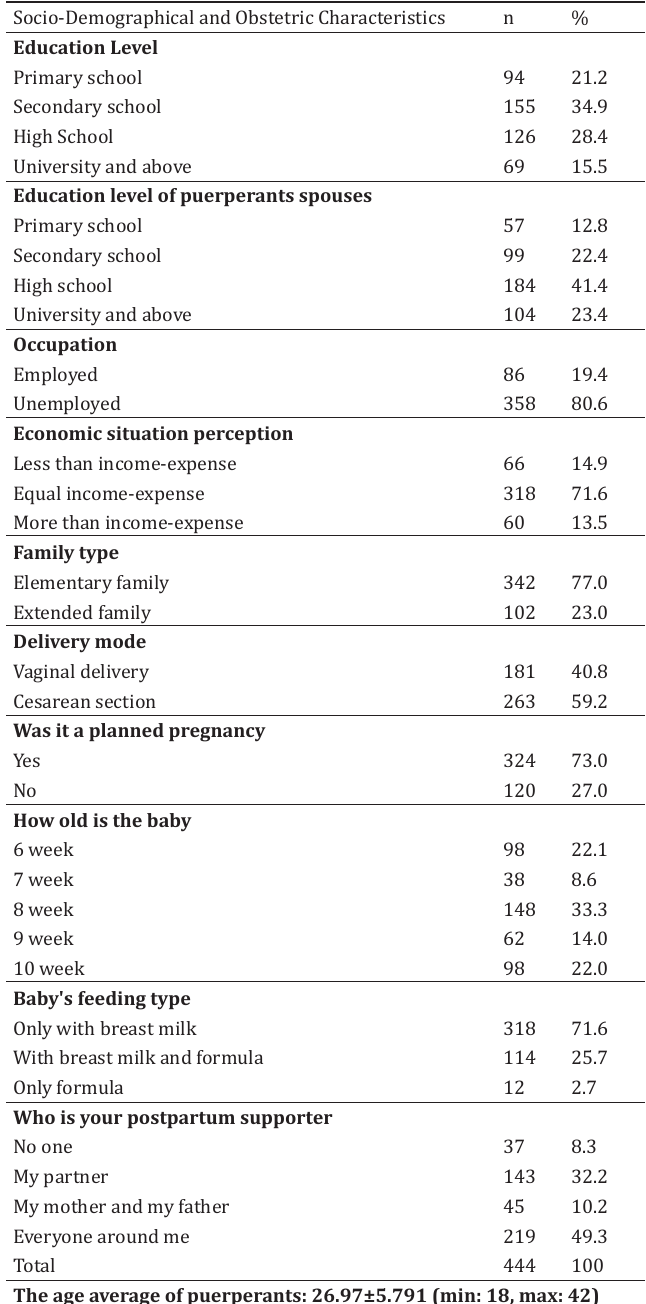
Distribution of Score Averages which Puerperants obtained in BIMF and BSES-SF Total and Sub-dimensions